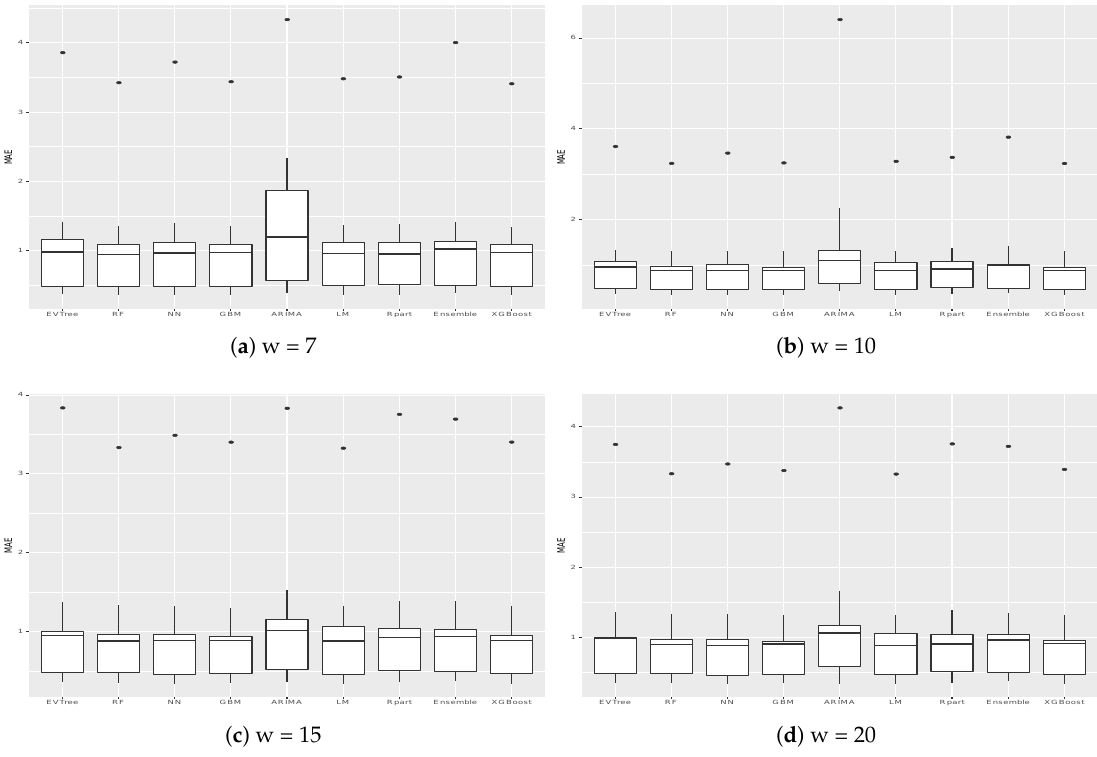
Figure 5. MAE obtained on all the buildings for different values of the historical window w